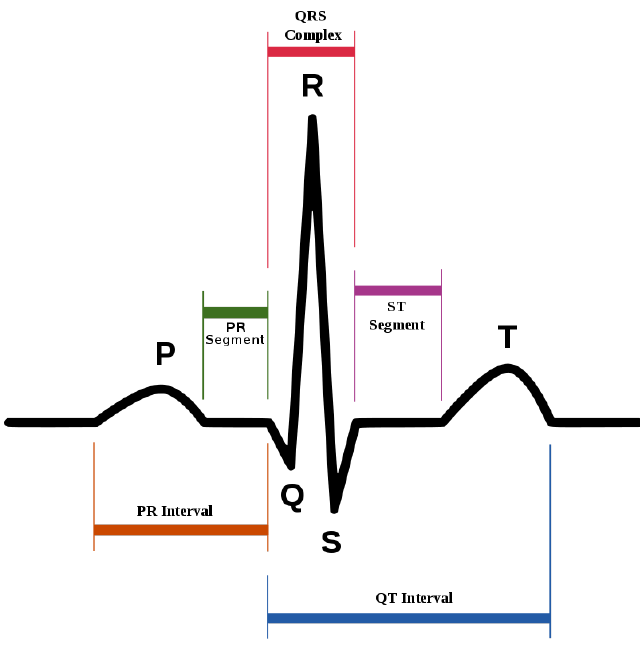
Figure 2. The standard waveform of ECG